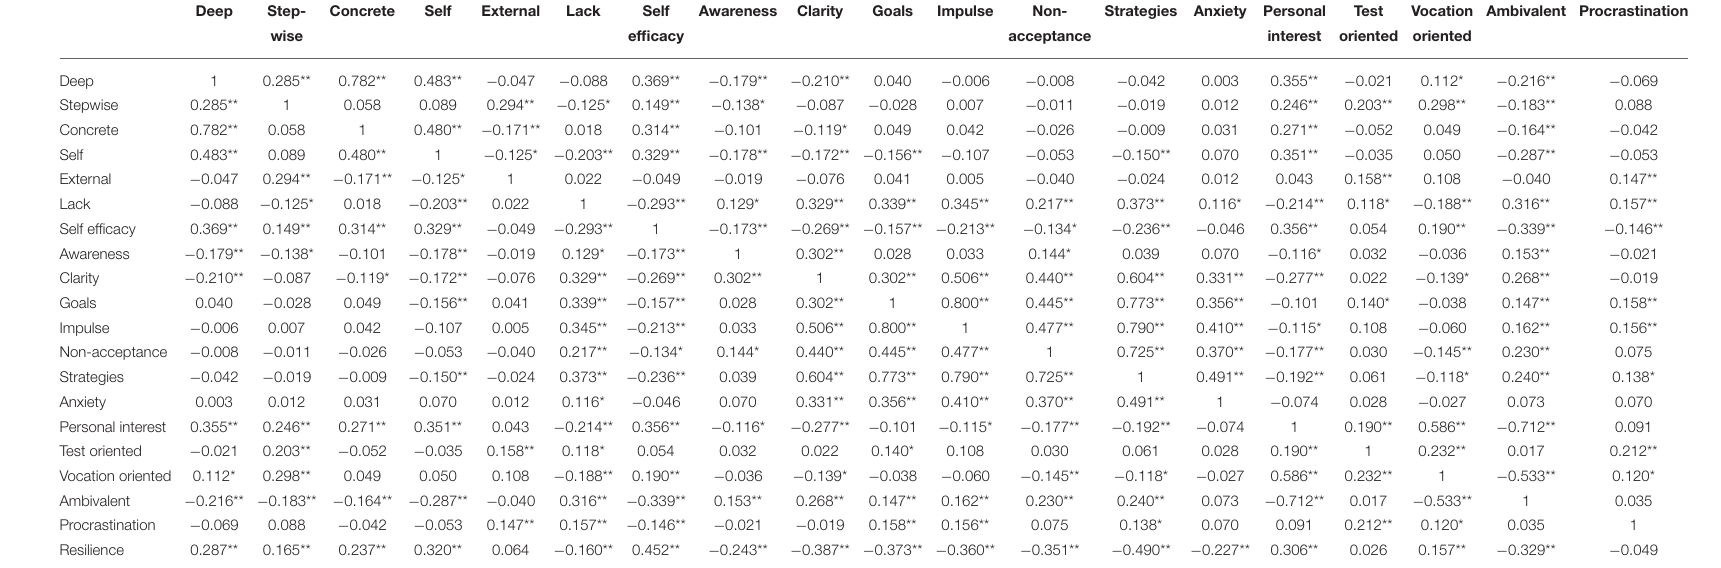
TABLE 3 | Pearson correlation coefficient among subscales (factor